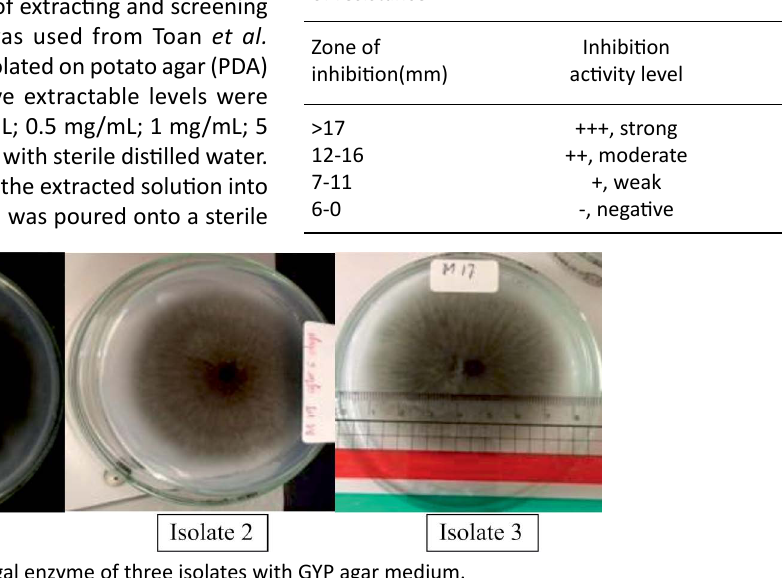
Table 1. Zone of inhibition and relative level of activity of